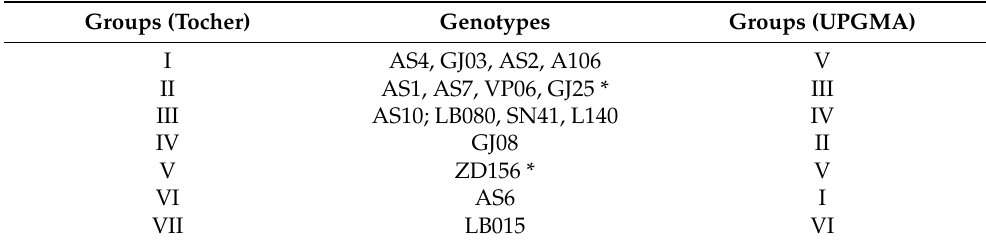
Table 4. Relative contribution of the macro- and micronutrient concentrations in flowers, grains, husks, and leaves to genetic diversity in 16 genotypes of Coffea canephora , according to the Singh method [25] and based on the Euclidean distance. Alta Floresta D’Oeste, Rond ô nia, Brazil. Variables S.j Value (%)